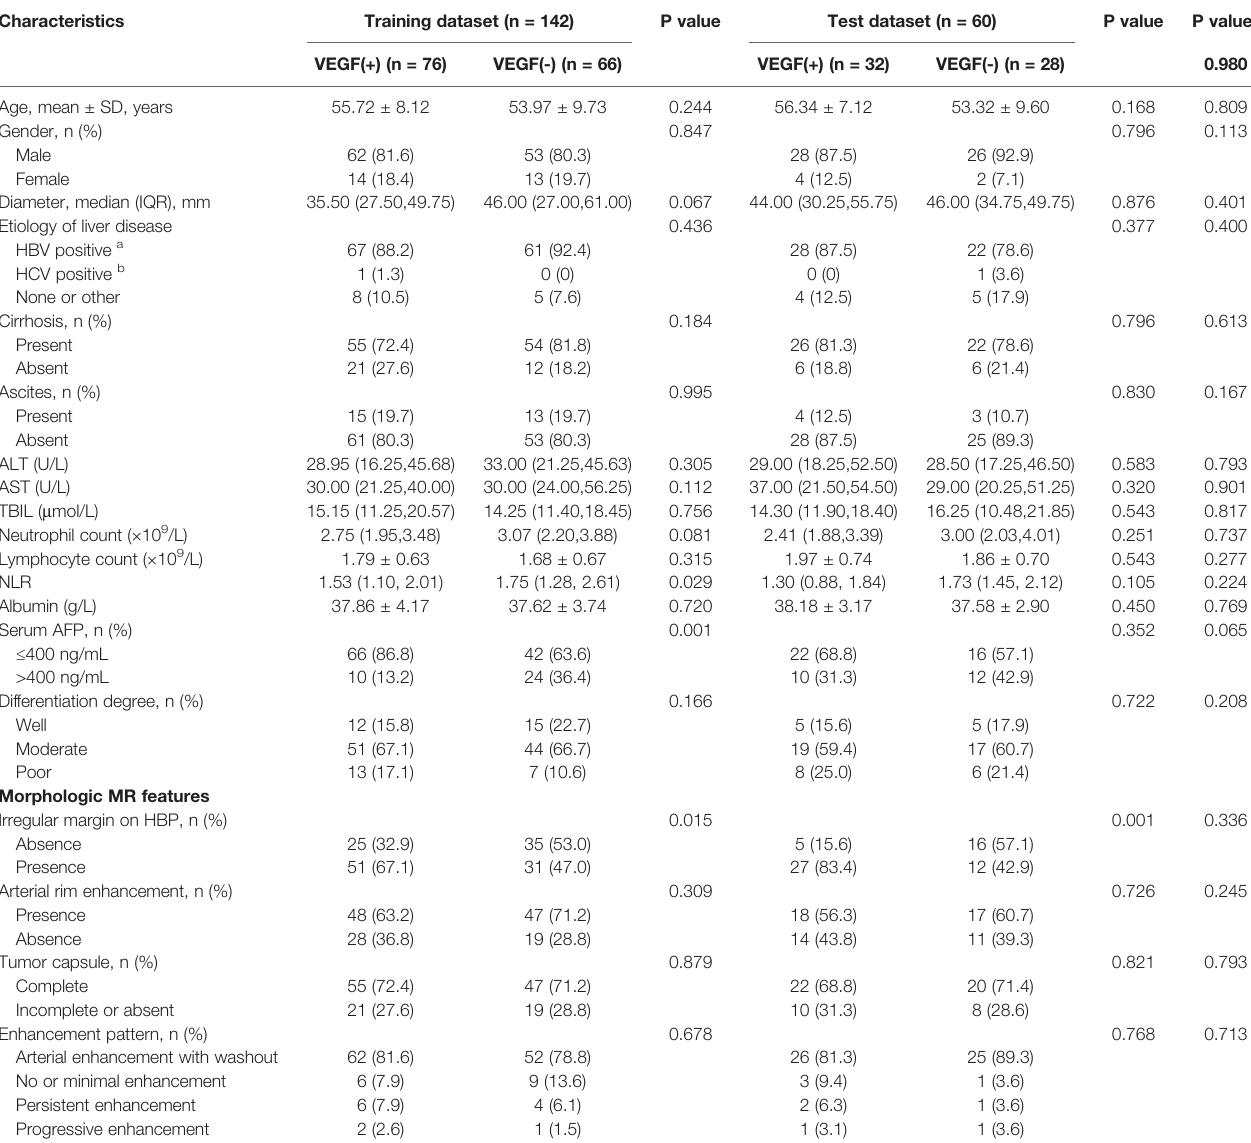
TABLE 1 | Patient characteristics in the training and test